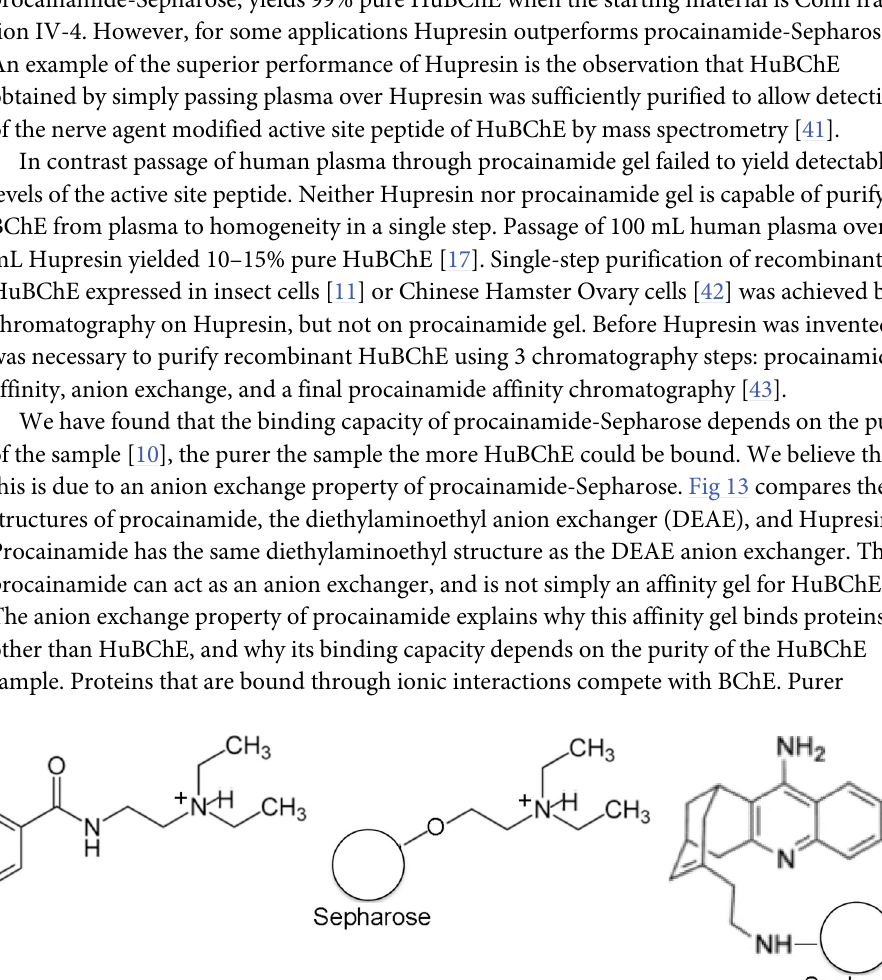
PLOS ONE | https://doi.org/10.1371/journal.pone.0209795 January 9,